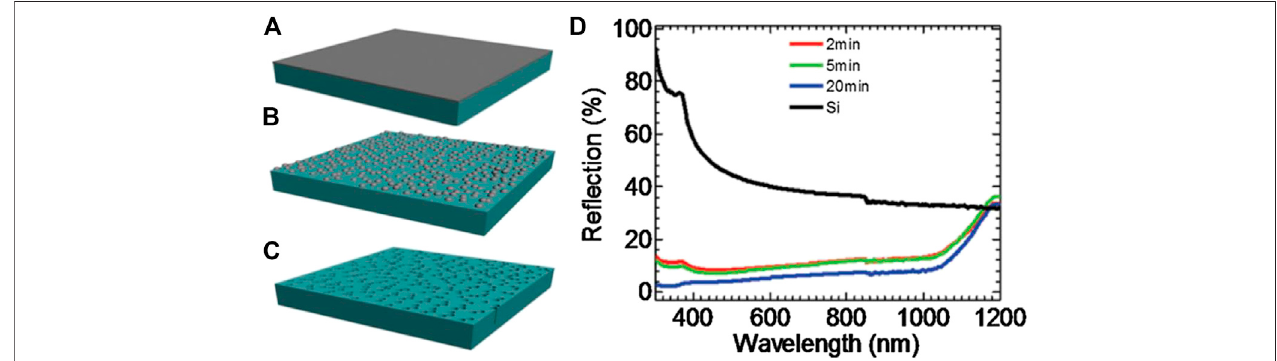
FIGURE 13 | Schematic illustration of the fabrication process of nanostructured Si: (A) Silver fi lm was deposited on the Si surface; (B) Silver nano-particles were formed afterannealingsilver fi lm inafurnace; and (C) Sisampleafter etchingintheHF and H2O2 solution. (D) Measuredre fl ection spectrafromnano-structuredSi fi lms with 9 nm silver fi lm and different etching times. Source : Reproduced from Ref. 4.